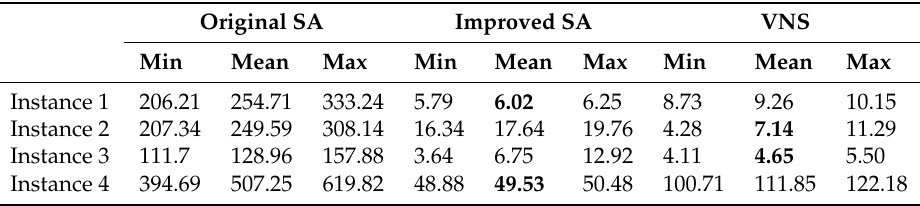
Table 7. Computation times (in minutes) in Phase 2.